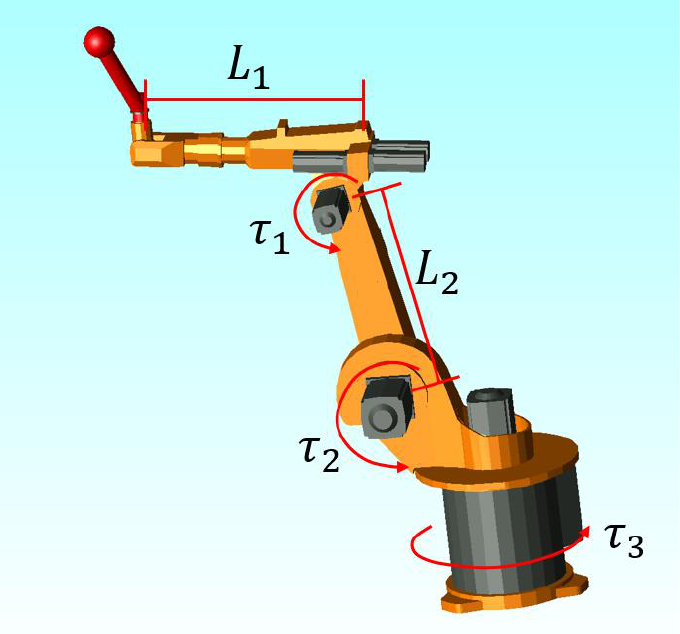
Figure 12. Structural diagram of the 3-DOF robot arm.